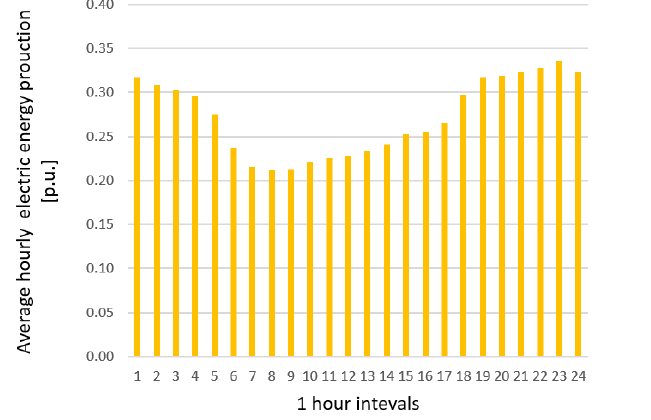
( b ) Figure 5. ( a ) Seasonal variability of electrical energy production of Wind Farm A; ( b ) Seasonal var- iability of electrical energy production of Wind Farm B. Figure 6 presents dispersion diagrams—relationships between wind speed forecasts [p.u.] for the beginning of a 1 h period of energy generation and actual production of electrical energy [p.u.] from Wind Farm A for 2 different NWP models (GFS and ECMWF). Figure 7 contains similar diagrams for Wind Farm B. For both figures, points are slightly more concentrated for the ECMWF model (cases b ). All dispersion diagrams indicate a non-linear relationship between wind speed and the yield of electricity. The exact shape corresponding approximately to the shape of the wind turbine power curve typical for a single turbine cannot be well seen on the diagram due to low concentration of data points. Both of the observed disadvantageous phenomena result probably from the following reasons: •